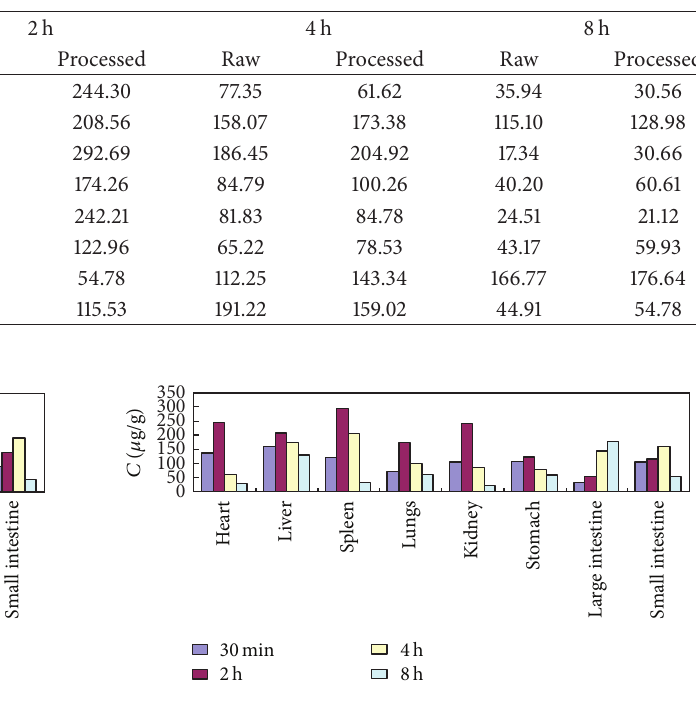
Figure 6: The concentration-time profile of (4 E ,6 E ,12 E )- tetradecatriene-8,10-diyne-1,3-diyl diacetate in tissues after oral administration of processed Atractylodis Rhizoma at a dose of 40 g ⋅ kg −1 to rats ( 𝑛 = 6